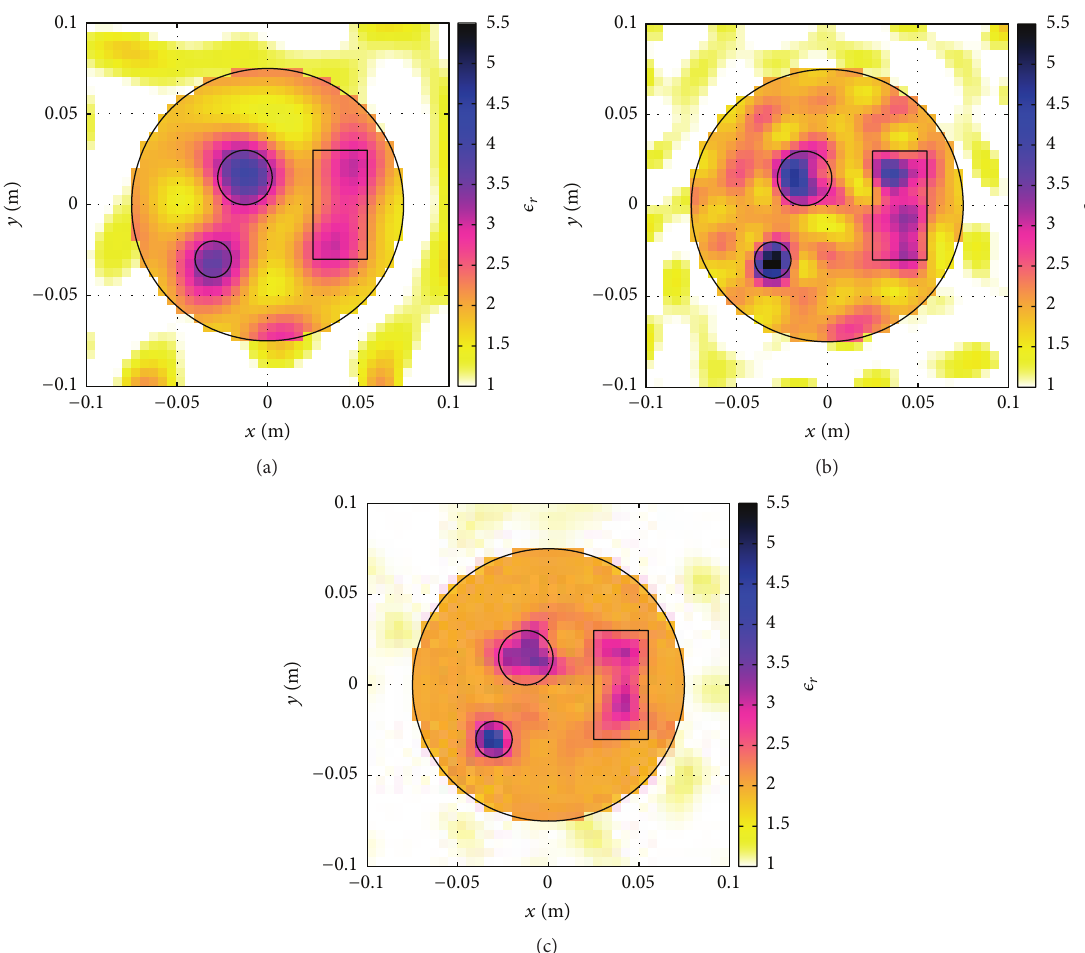
Figure 3: Reconstructed distributions of the relative dielectric permittivity of the investigation domain in different operating conditions, with 𝑆 = 20 and SNR = 5 dB: (a) 𝐹 = 1 , 𝑝 = 2.0 ; (b) 𝐹 = 3 , 𝑝 = 2.0 ; (c) 𝐹 = 3 , 𝑝 = 1.3 .